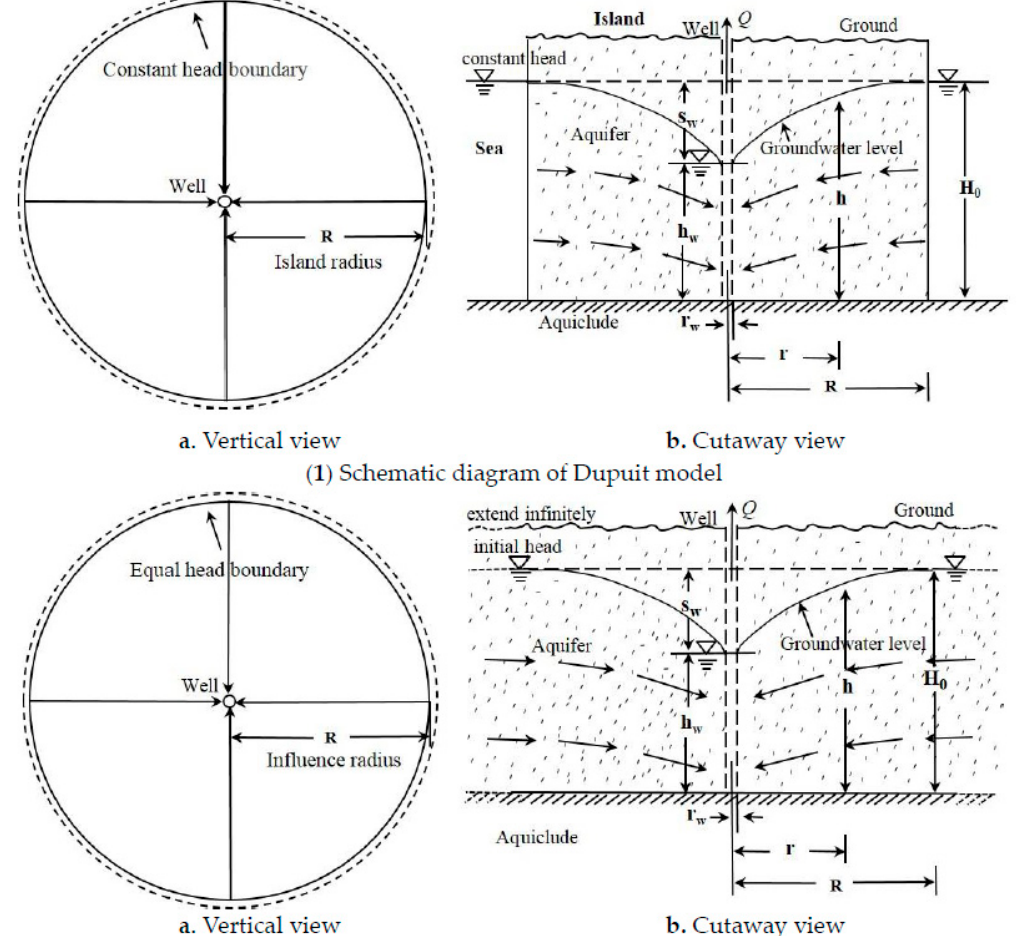
Figure 1. Schematic diagram of Dupuit model and Thiem model. Q is the water yield of the pumping well, [L 3 T − 1 ]; s w is the drawdown of the pumping well, [L]; h is the groundwater level at distance r from the pumping well, [L]; H 0 is the thickness of the aquifer, [L]; h w is the water level of the pumping well, [L]; r w is the radius of the pumping well, [L]; r is the distance between the pumping well and observation well, [L]; and R is the influence radius, [L].